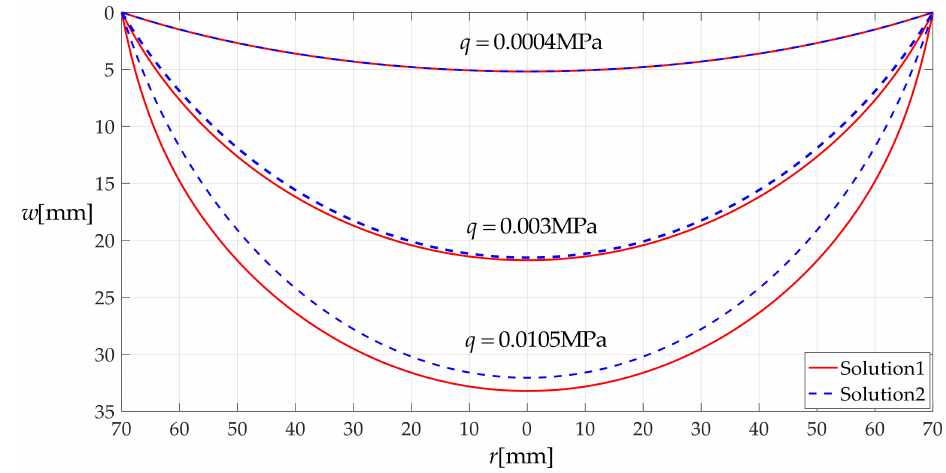
Figure 15. Variation of w with r when q takes 0.0004, 0.003, and 0.0105 MPa,